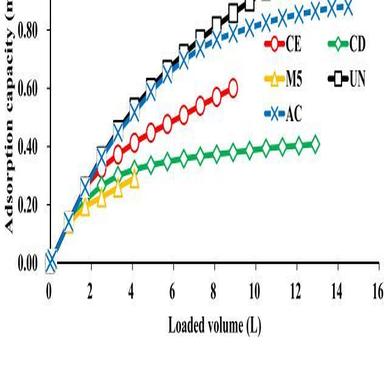
Adsorption capacities of the tested adsorbents toward low FA concentrations (0.1–0.5 ppm) (ambient temperature and 2 mg adsorbents).